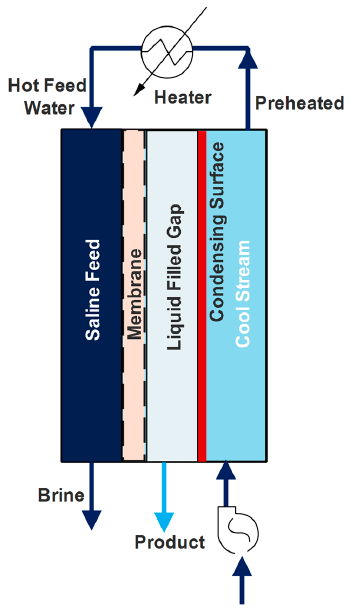
Figure 8. Schematic diagram of permeate-gap membrane distillation (PGMD) [86].